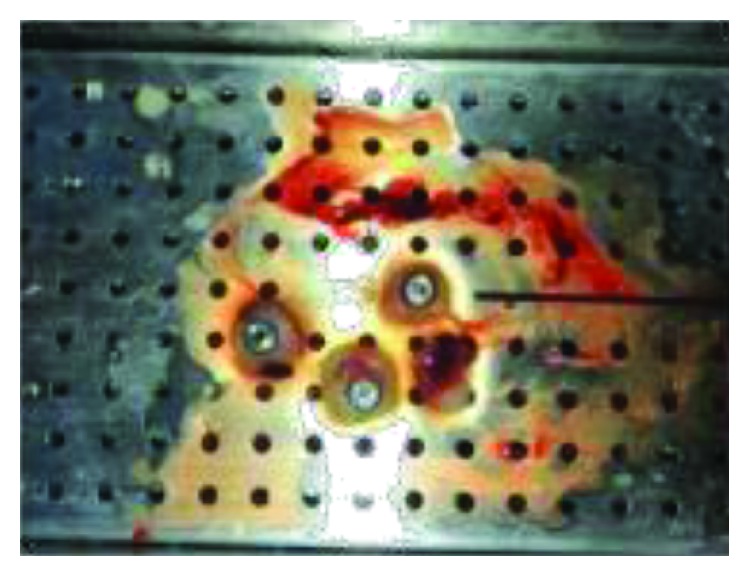
Poncho technique.